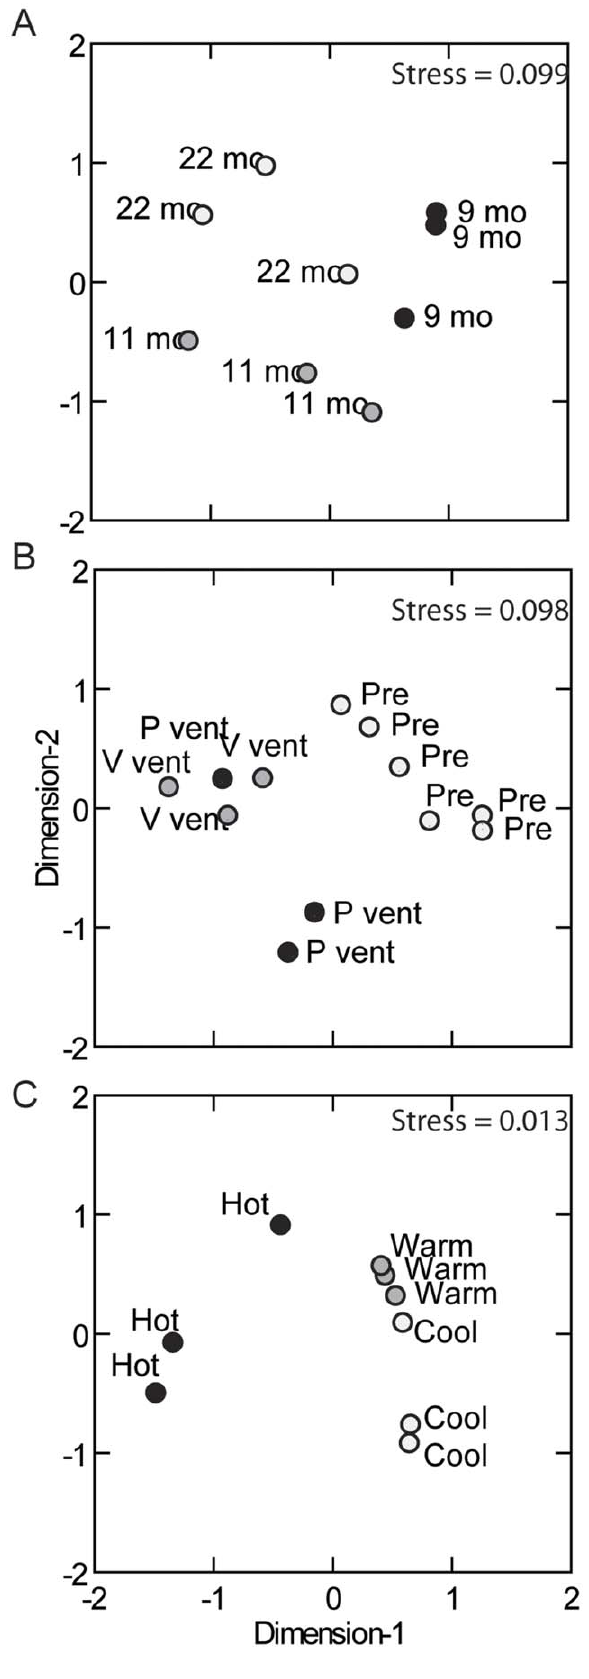
Figure 3. Non-metric multidimensional scaling analysis (nMDS) of colonist species composition. Closely clustered symbols correspond to samples with similar species composition and abun- dance. Comparisons are made: (A) across Time (9, 11 and 22 months after eruption at P-vent hot habitat); (B) between Disturbance history (pre-eruption at Biovent and Worm Hole hot habitat, and post-eruption at P-vent and V-vent hot habitat); and (C) between Habitat (hot, warm and cool habitat at P-vent, 11 months post-eruption). Stress values near zero indicate that most of the variance in species abundance was accounted for in the